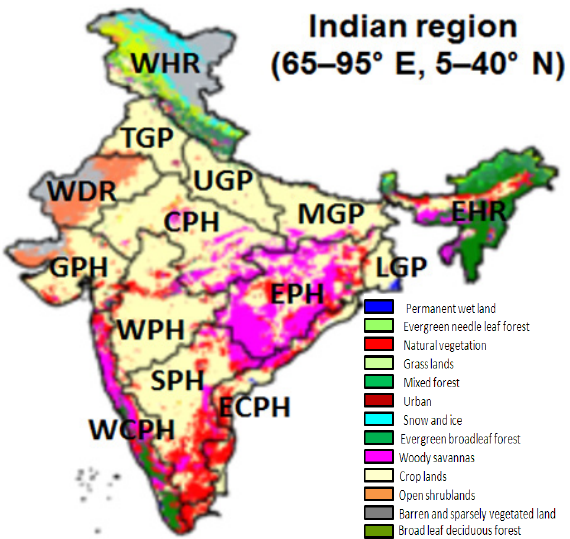
Figure 1: Study area generated from MODIS global land cover data showing different land covers with agro-climatic zone boundary (Abbreviation of the agro-climatic zones are: WHR: Western Himalayan Region; TGP: Transgangetic plains; UGP: Upper Gangetic Plains; MGP: Middle Gangetic plains; LGP: Lower Gangetic Plains; ECPH: East coast plains and Hills; WCPH: West coast plains and Hills; EPH: Eastern Plateau and Hills; CPH: Central Plateau and Hills; WPH: Western Plateau and Hills; SPH: Southern Plateau and Hills; GPH: Gujarat plains and Hills; WDR: Western Dry